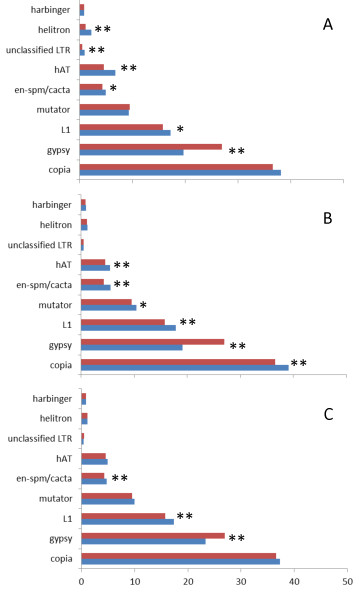
Comparison of TE hits in and around genes to TEs in the genome. A. In all scaffolds over 1 Mb vs. inside genes, B. In all scaffolds over 1 Mb vs. the adjacent 1kb up and downstream of genes, C. In all scaffolds over 1 Mb vs. the adjacent 5kb up and downstream of genes. The bars represent the percentage of the hits of each superfamily among all transposon hits in the scaffolds (red) or inside and in the adjacent gene regions (blue). Asterisks represent significance after Bonferroni correction at: *p < 5 x 10-3 or **p < 5 x 10-4.